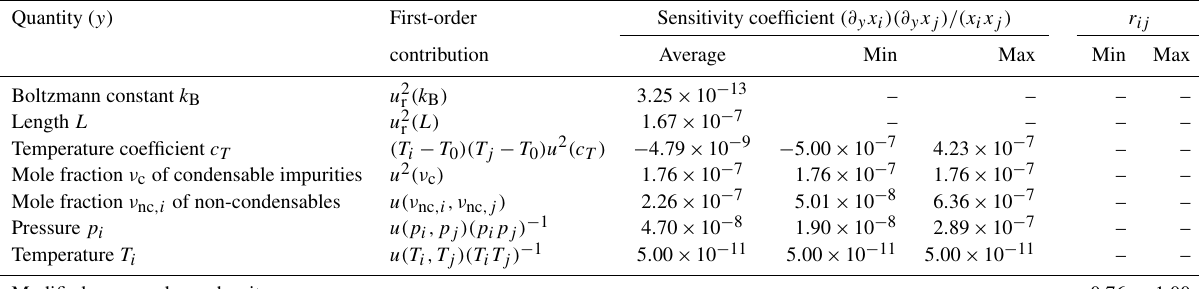
Table 3. Contributions to correlation coefficients between different realisations x i and x j of the ozone column ( i (cid:54)= j ). Quantity ( y